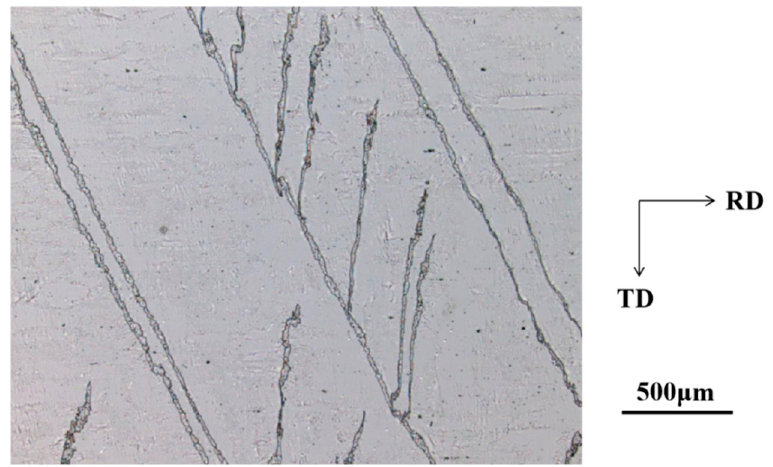
Figure 2. SEM micrographs in deformation twinning area of 0.075mm sheet in rolling plane.